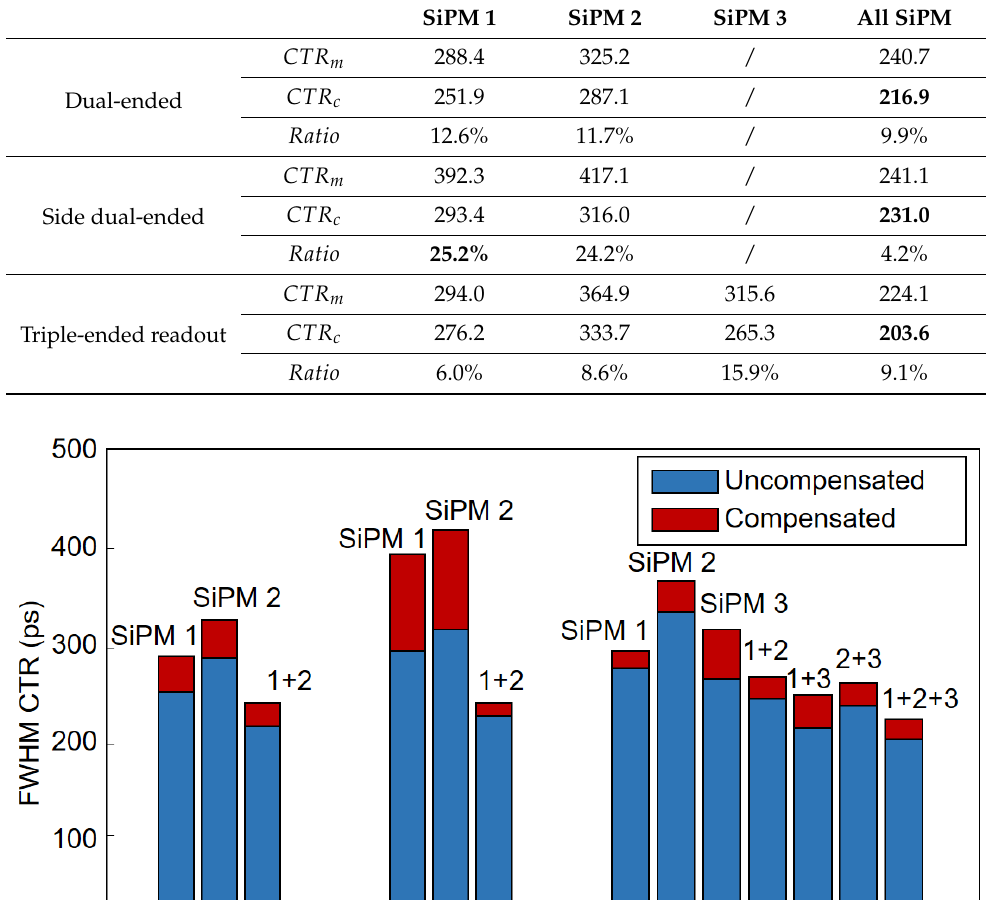
Table 3. FWHM CTRs of multi-ended readout detector.